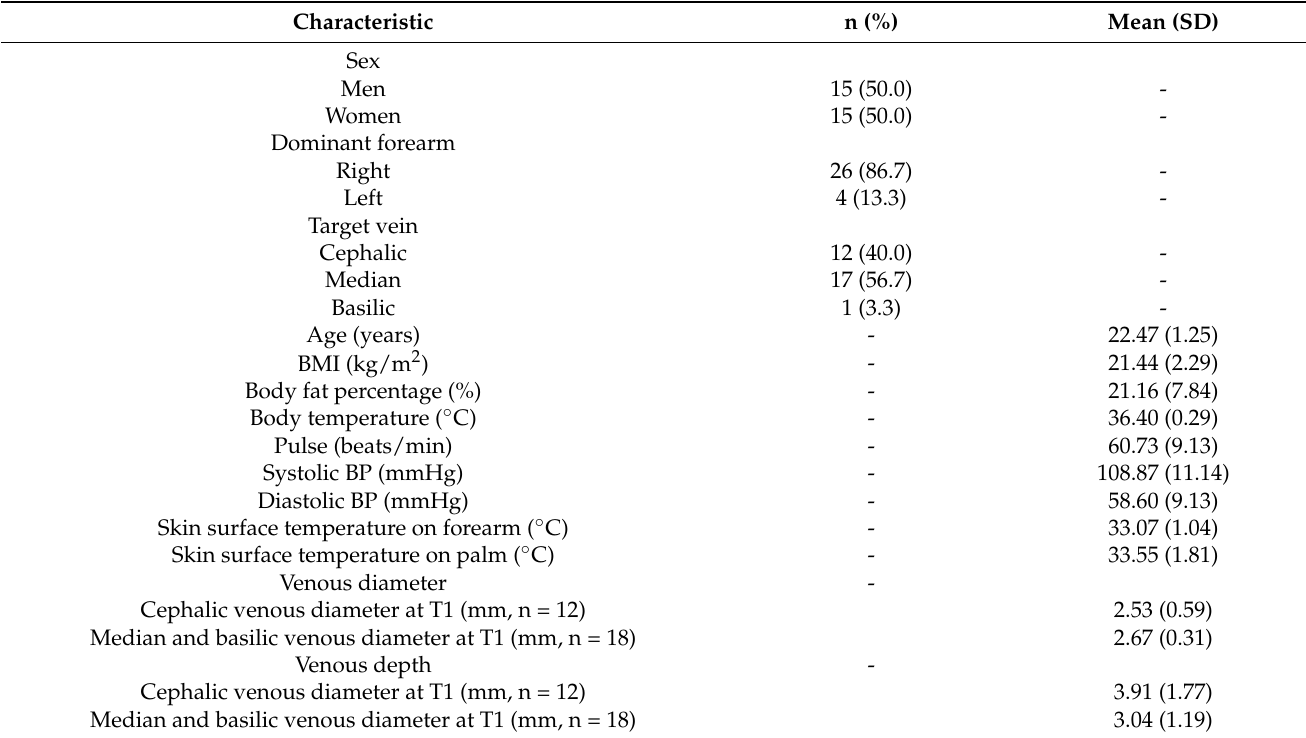
Table 1. Participants’ characteristics (n = 30).